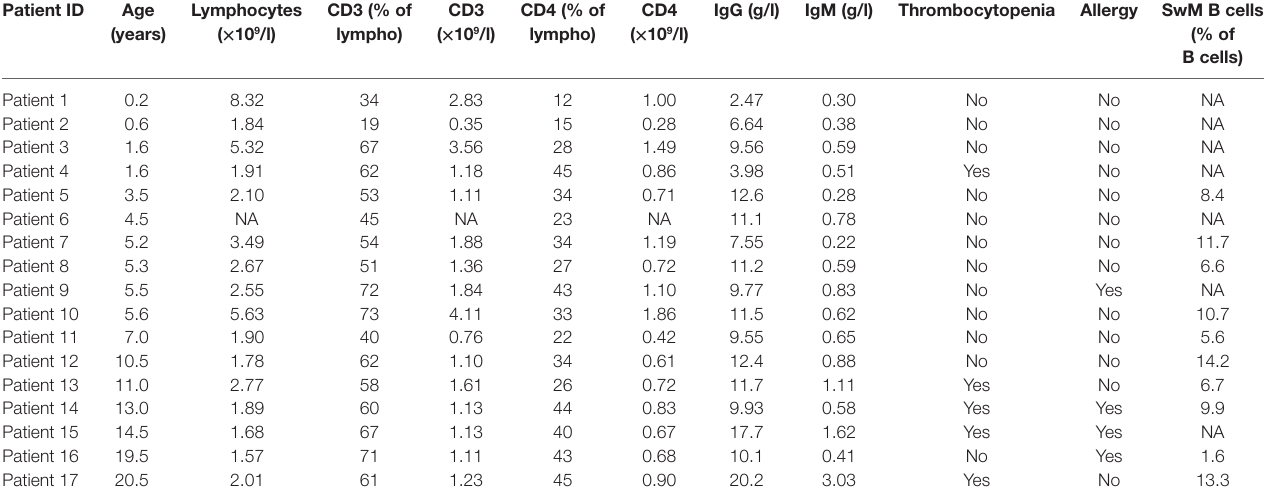
Table 1 | Cohort characteristics.